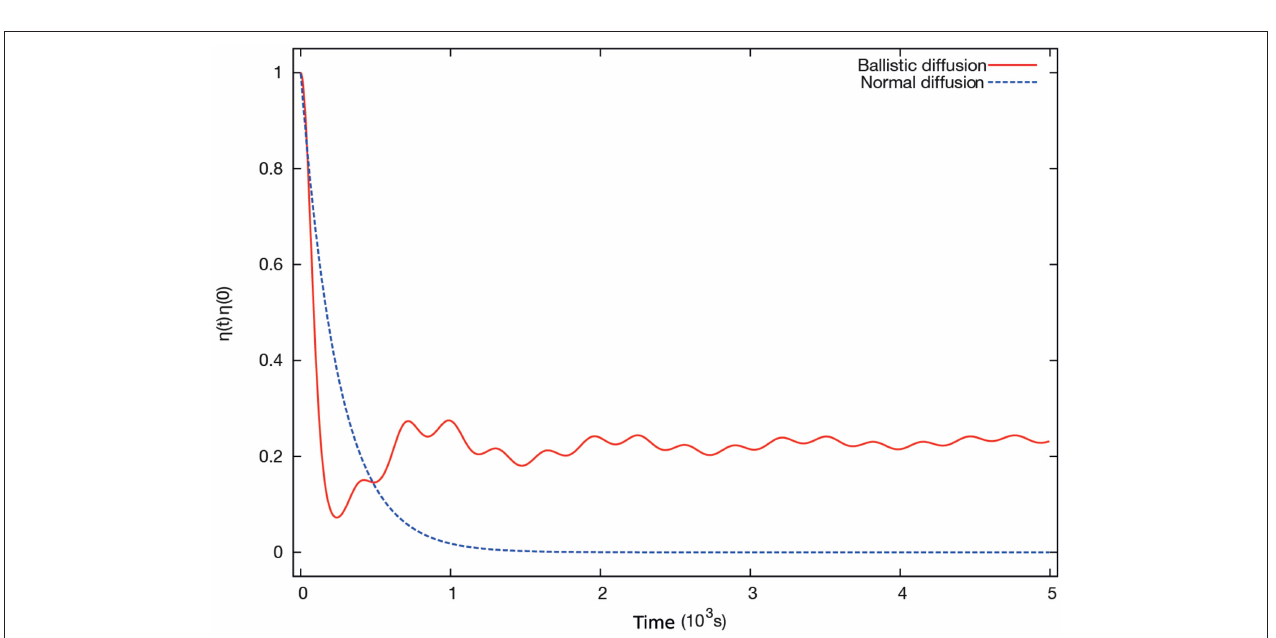
FIGURE 4 | (Color online) Time evolution of the normalized non-Gaussian factor η ( t ) /η (0) for normal and ballistic diffusion. In both cases, we consider the initial PDF as a Laplace distribution with unit mean and unit variance. The functions R ( t ) are as in Figure 5 . From Lapas et al. [83], with permission from Europhysics Letters.